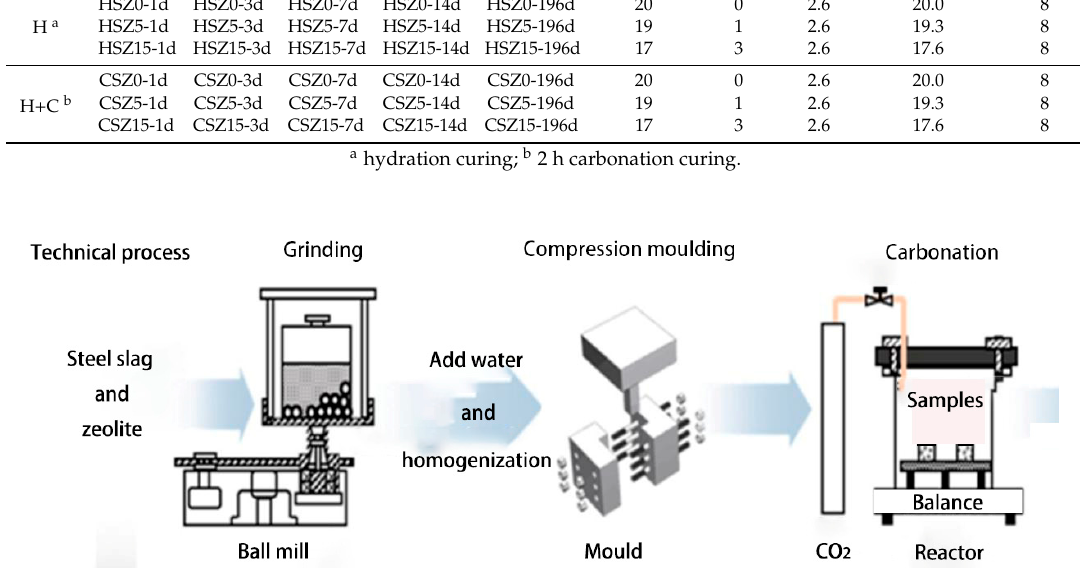
Figure 3. Schematic illustration used to produce steel slag cubes containing different ratios of zeolite.